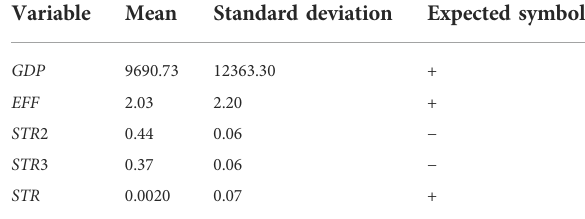
TABLE 2 Linear regression